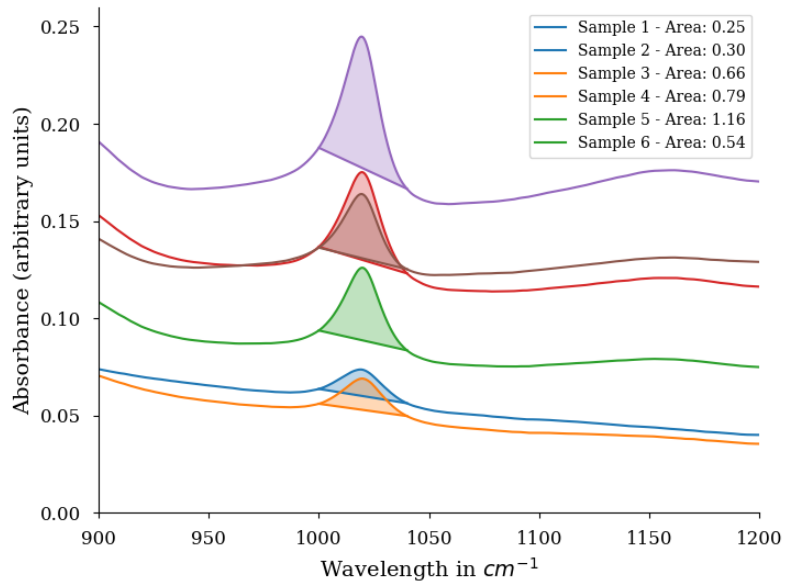
Figure 2. Example of Area under the curve (AUC) calculations for Fourier Transfor Infrared Spec- troscopy (FTIR) measurements. The specific peak shows a Lepidocrocite peak at 1100 cm − 1 . Sample 7 is excluded from this graph to improve the